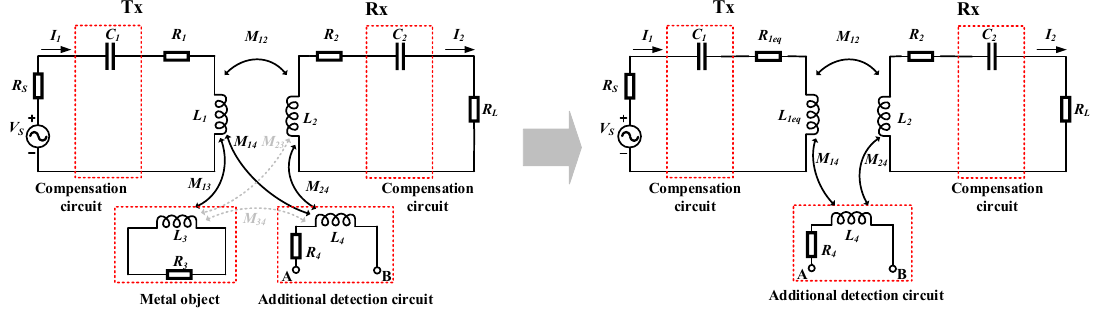
Figure 10. Equivalent circuit of the passive detection method.